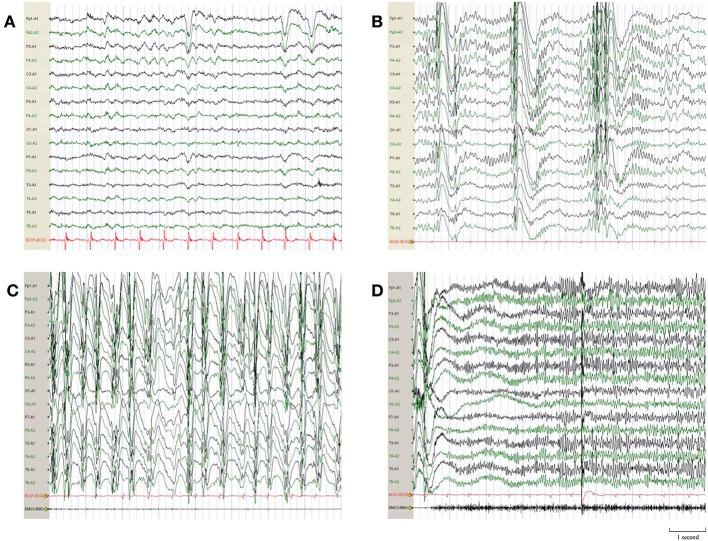
EEG demonstrations before quinidine therapy. (A) Interictal EEG before quinidine therapy showed a large number of 3–5 Hz slow waves with middle and high amplitude in the anterior region in background. (B) Multiple-spike-and-slow-waves of 0.5–1 Hz were observed during the sleep period. (C) Slow spike-and-slow-waves of 1.5–2.5 Hz were observed when the patient was awake. (D) Ictal EEG of the tonic seizure showed short-term fast rhythms burst of 16–20 Hz.